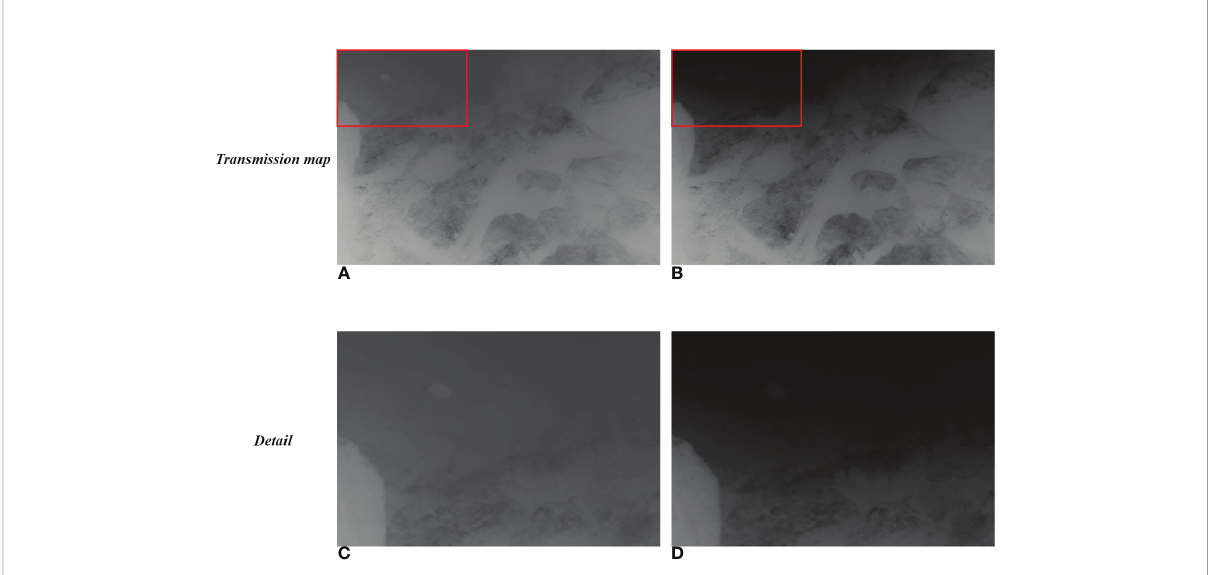
FIGURE 4 Comparison of the transmission maps. (A, B) images are the transmission map estimated using the dark channel prior (DCP) and the adaptive correction of channel differential and fusion (ACCDF) method, respectively. (C, D) images are the details of (A, B)